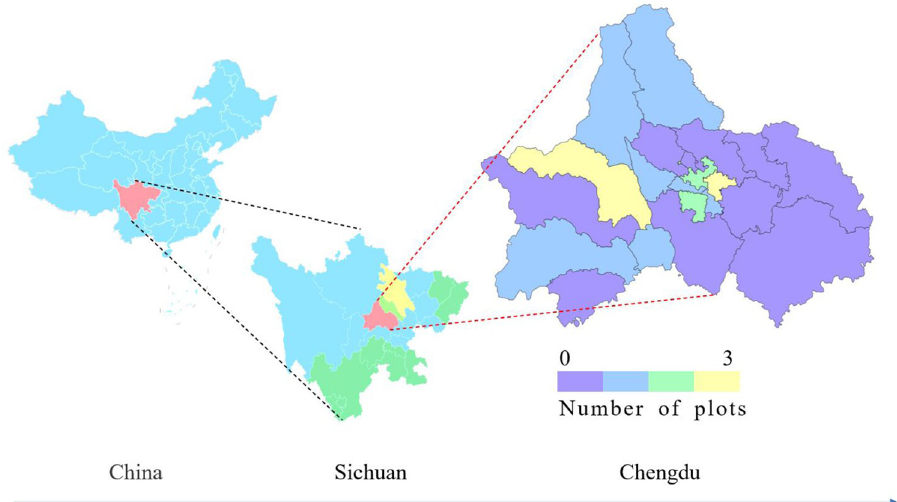
Fig 6. Distribution of contaminated plots in